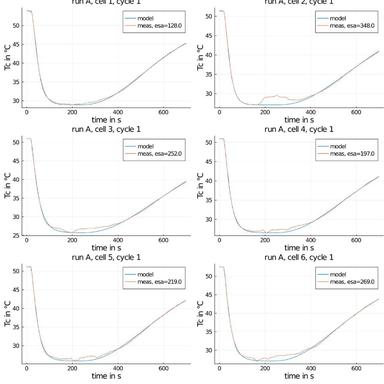
Temperature profiles in run A, first drying cycle.